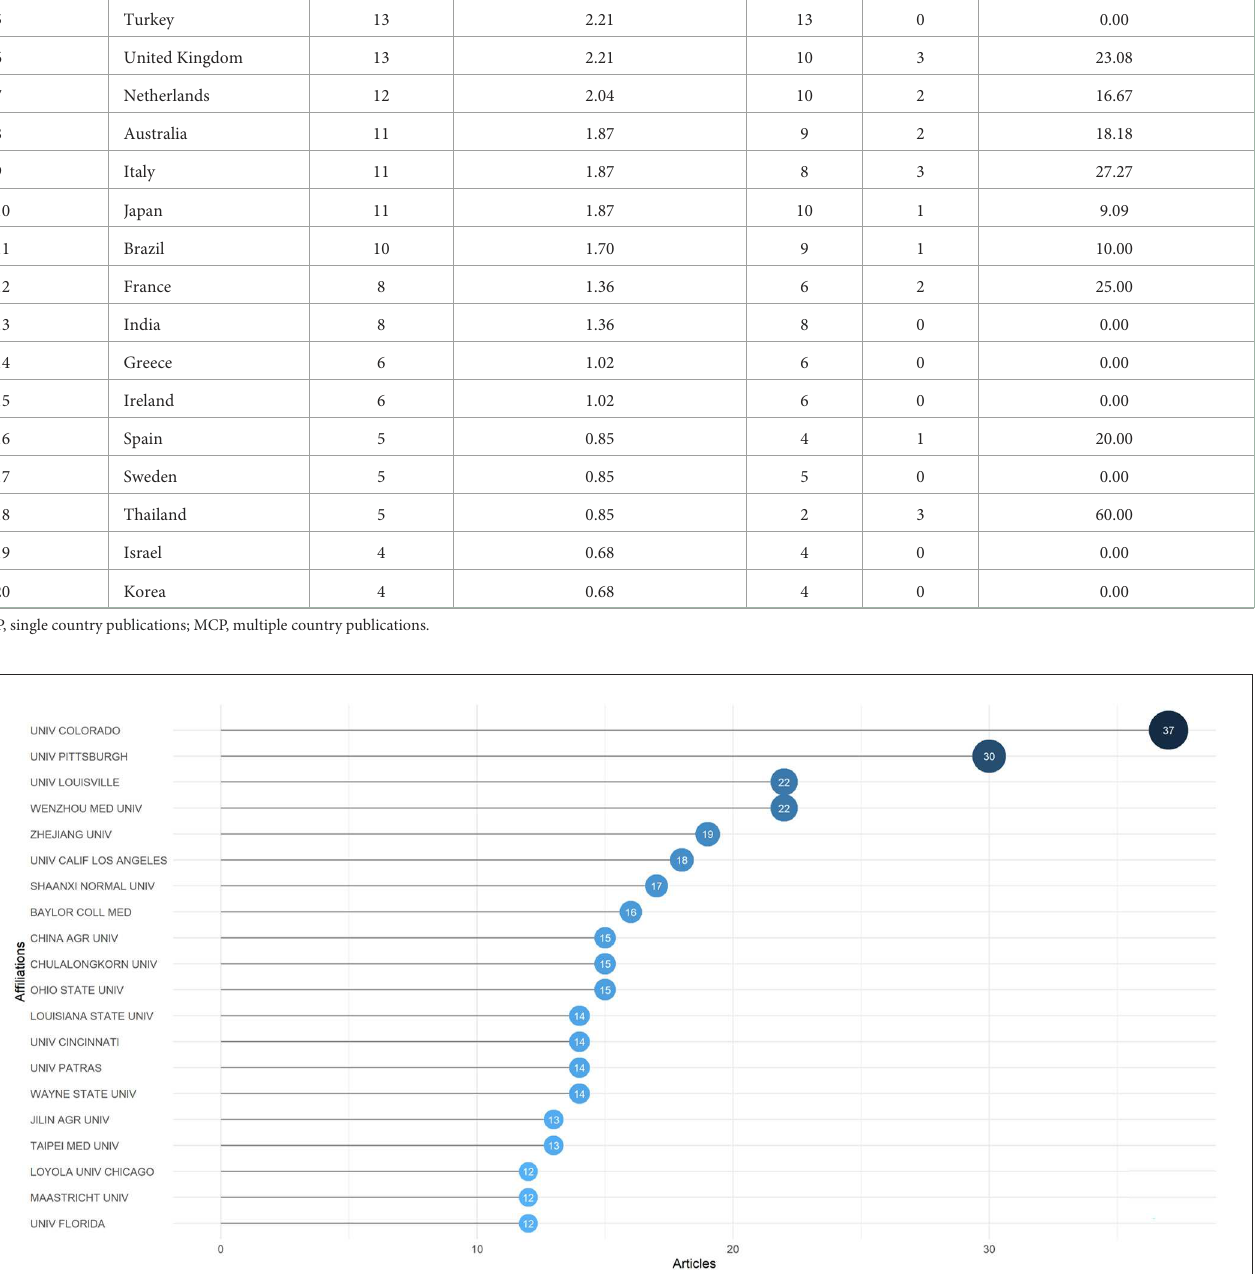
1976 to 2022, accounting for 43.52% of all the documents. Based on Bradford’s law, the top 11 productive journals were fetched to be the core journals (Supplementary Figure S1B). As presented in Table 2,